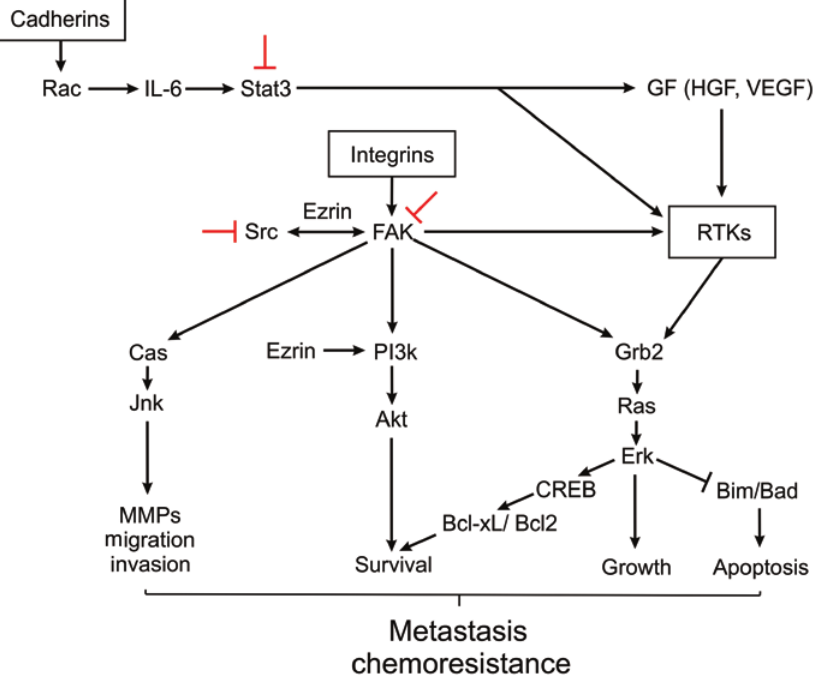
Figure 4: The Cadherin/Stat3-Integrin/Fak signaling axis in cancer metastasis. Both cell-cell and cell-matrix adhesions are important for tumor formation and metastasis. Classical cadherins (E, N, 11) mediate cell to cell interactions and activate Stat3 through Rac/IL-6, thereby upregulating cellular survival [reviewed in (14)]. Stat3 can also activate transcrip- tion of growth factors HGF and VEGF, as well as the RTK Met (162). Cell-ECM adhesion is mediated through integrin receptors that bind to the FAK/Src complex (120). Binding of the p85 subunit of PI3k to FAK-ptyr397 activates the PI3k/Akt survival pathway. Ezrin also promotes activation of the Src/FAK complex, and can activate the PI3k/Akt axis and survival independent of FAK (137). In addition, recruitment of Grb2 to FAK-ptyr925 leads to activation of the Ras/MEK/Erk1/2 pathway, which in turn stimulates cell cycle progression through cyclin D1 upregulation and decreased p21 expression. ERK1/2 also upregulates the Bcl-xL/Bcl2-dependent cell survival pathway through the cAMP response element-binding (CREB) protein, with concomitant down regulation of pro-apoptotic proteins Bim and Bad through ubiquitina- tion and degradation. FAK-ptyrY861 promotes increased binding of p130cas to the proline rich domains PR2 and PR3 of FAK. Activation of p130cas and c-Jun N-terminal kinase (JNK) induces expression of MMPs required for cell migration and invasion. Interestingly, despite the fact that mutationally activated Src is a potent Stat3 activator, the integrin/FAK/Src signal is insufficient to activate Stat3. Red markers indicate potential drug-target strategies. Collectively, these signaling events underscore the importance of Cadherin/Stat3 and Integrin/ FAK signaling as pro-metastasis and chemo-resistance pathways and potential targets for anti-cancer